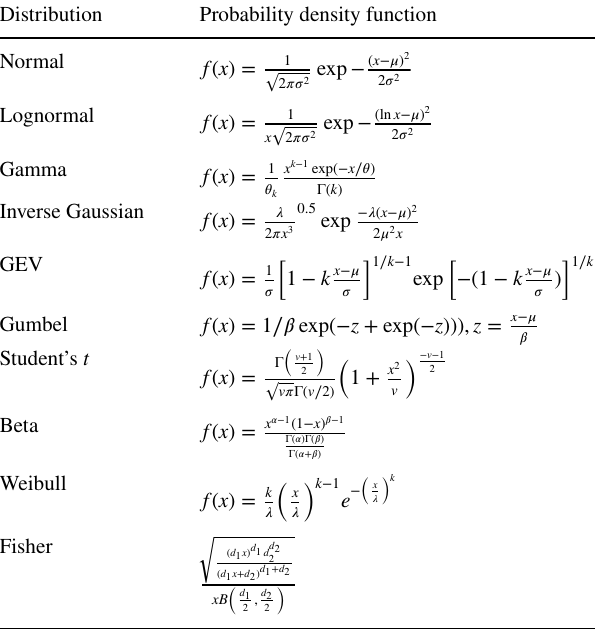
Table 1 Probability density functions of different distributions used to fit the rainfall data. VanderPlas et al. (2012), Ghosh et al. (2016) Distribution Probability density function